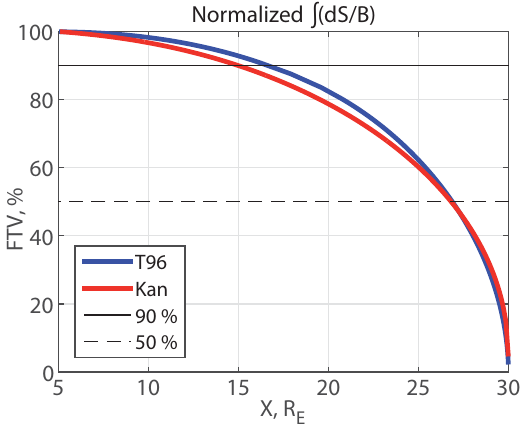
( d S/B) normalized to the full Figure 3. Flux tube volume R (x,z) ( 30 , − 2 . 4 ) ( d S/B) , in percent, calculated by T96 model (blue) FTV R ( 5 , 1 . 5 ) ( 30 , − 2 . 4 ) and by the Kan model (red) for the quiet conditions with tilt an- gle PHI = 30 ◦ clockwise (model parameter ϕ = − 60). Other model parameters are given in the legend of Fig. 4b. The Earth is on the